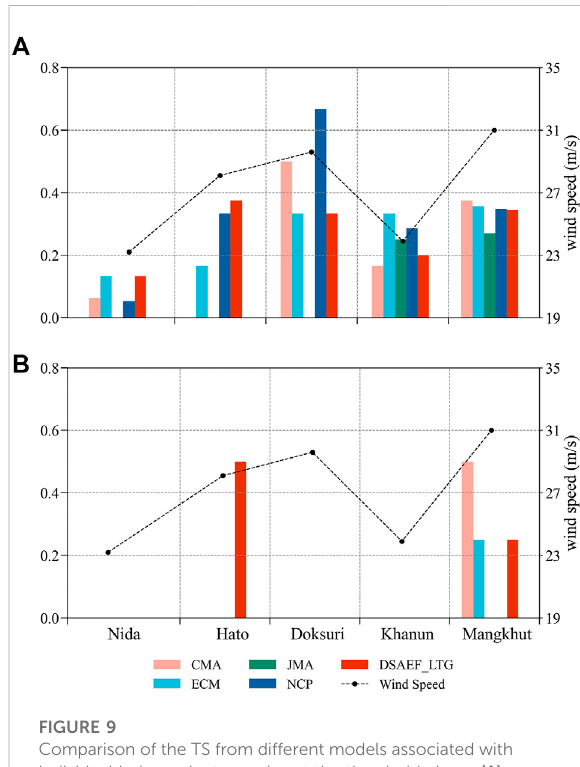
FIGURE 9 Comparison of the TS from different models associated with individual independent samples at the threshold above (A) Beaufort Scale 7 and (B) Beaufort Scale 10. The wind speed (black dotted line) is the largest value selected from the potential maximum gales of all stations for each TC (unit: